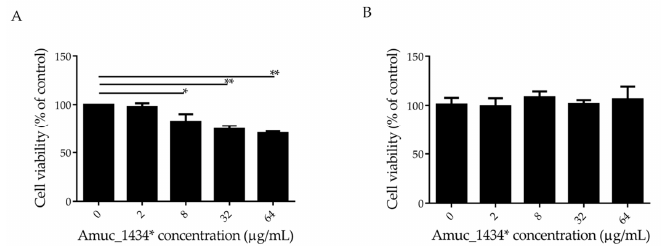
Figure 1. Amuc_1434* inhibited the proliferation of colorectal cancer LS174T cells. ( A ) LS174T cells and ( B ) Human epidermal melanoma (HEM) cells treated with various concentrations (0, 2, 8, 32, and 64 µ g / mL) of Amuc_1434* for 24 h. The viability of LS174T and HEM cells was detected via 3-(4, 5-dimethylthiazol-2-yl)-2,5-diphenyltetrazolium bromide (MTT) assay. (Data are expressed as mean ± standard deviation, n = 3, *: p < 0.05; **: p < 0.01.).